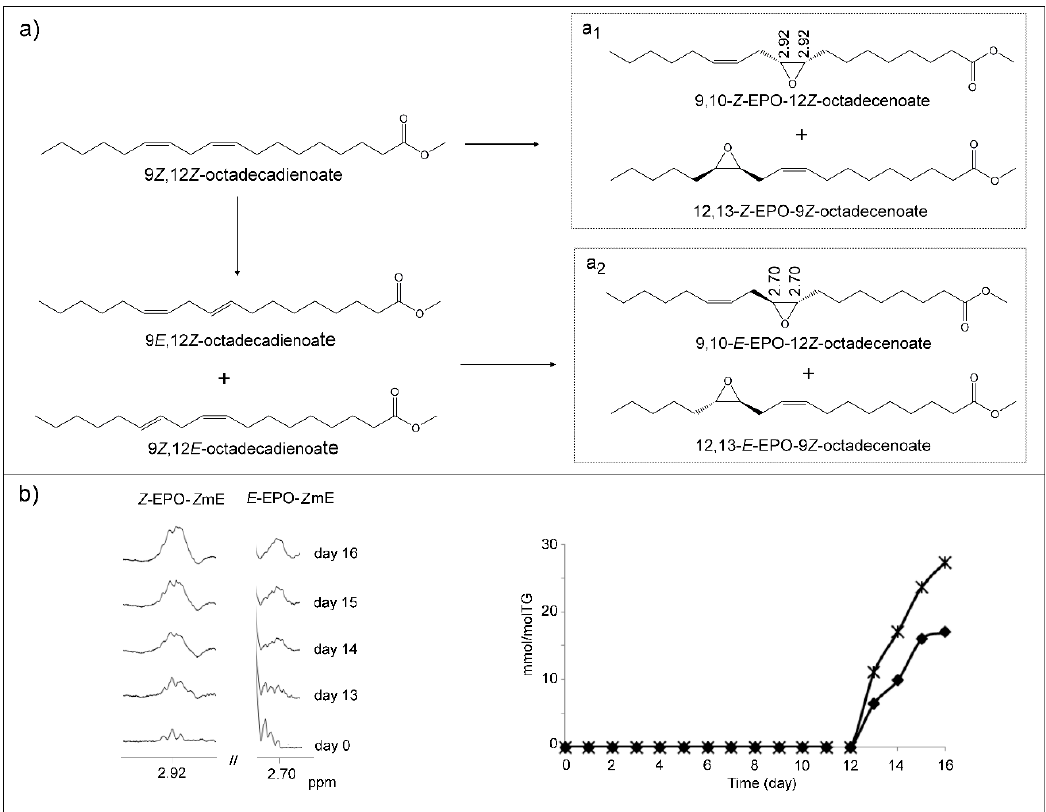
Figure 11. Pathway of formation of monoepoxy-monoenes (mEPO-mEs) proposed by some authors under certain oxidation conditions [75]. ( a 1 ) Formation of Z -EPO-mEs together with some chemical shifts (ppm) of the 1 H NMR signals of their epoxydic hydrogen atoms; ( a 2 ) formation of E -EPO-mEs together with some chemical shifts (ppm) of the 1 H NMR signals of their epoxydic hydrogen atoms. ( b ) Enlargement of regions of the 1 H NMR spectra in which the signals of these compounds appear together with evolution of their concentration, expressed as mmol/mol TG versus time given in days of: Z -EPO- Z mEs (*); E -EPO- Z mEs ( ♦ ).